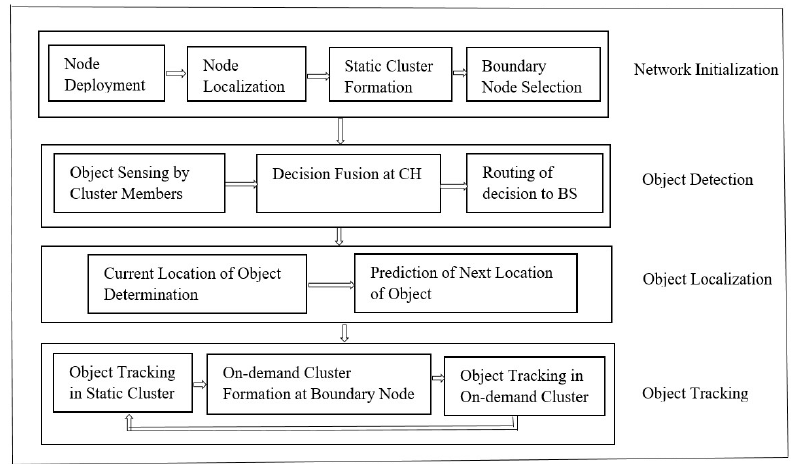
Figure 4. Proposed energy-efficient object detection and tracking framework.